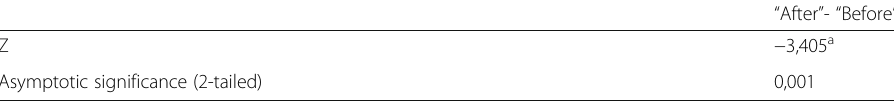
Table 8 Wilcoxon Signed-ranks